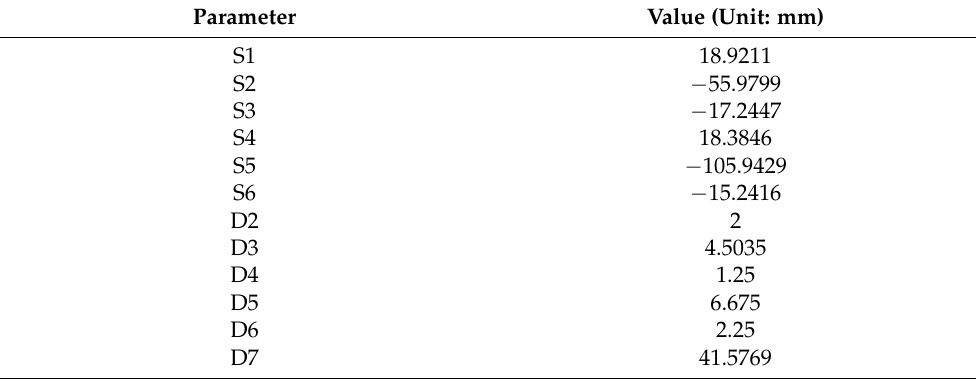
Table 7. Initial design parameters of Cooke triplet (Case 2).